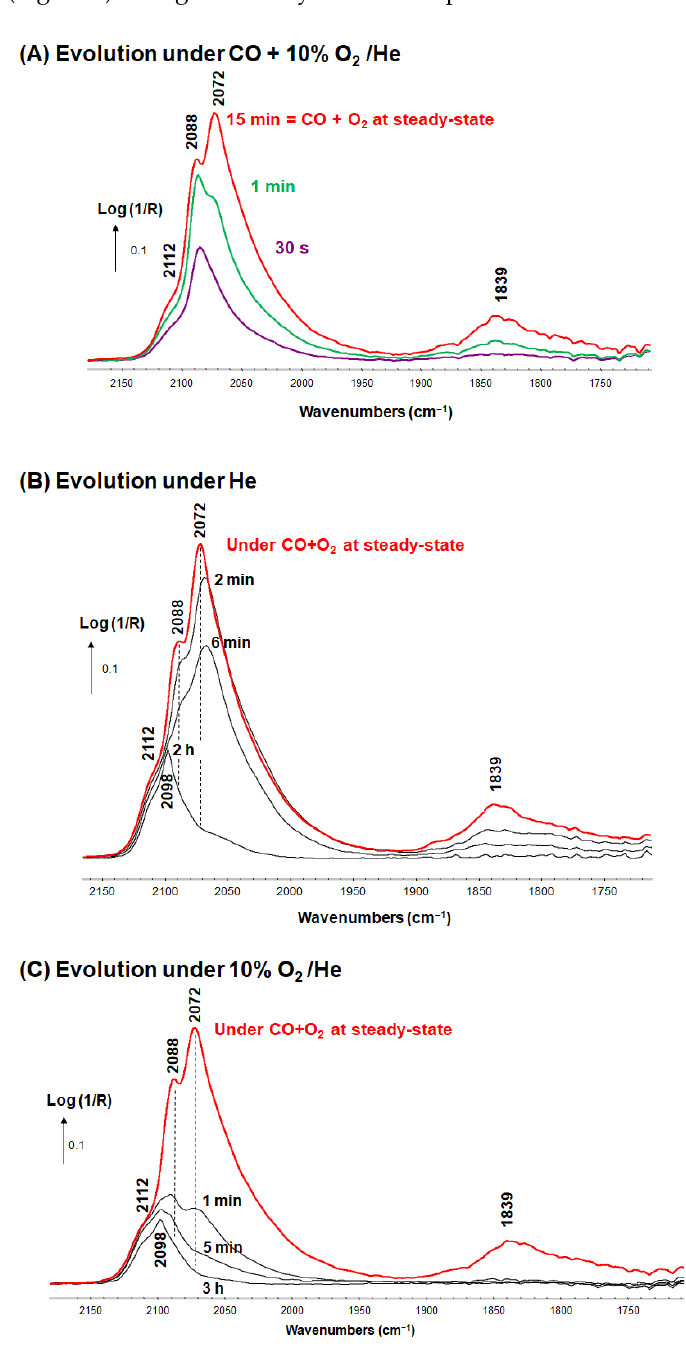
Figure 6. Evolution of DRIFTS spectra over Pt/TiO 2 recorded at 30 ◦ C as a function of time under ( A ) 0.5% CO + 10% O 2 /He for 15 min. The sample was then exposed to either ( B ) pure He or ( C ) 10% O 2 /He. Total flow rate: 100 mL/min. The sample was initially left 15 min under 10% O 2